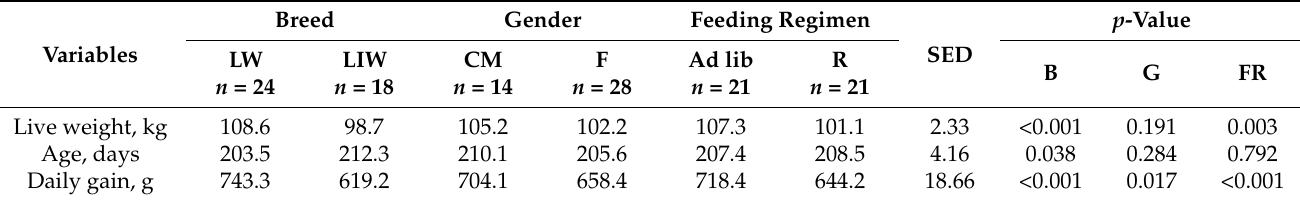
Table 2. Growth performance and live weight of pigs at slaughter.